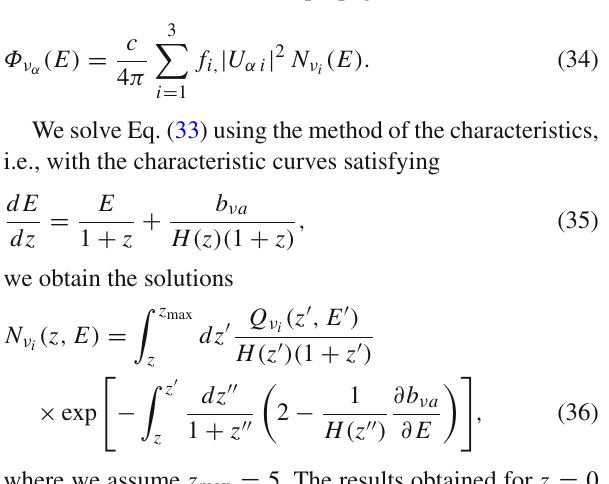
and the neutrino flux after the propagation is found